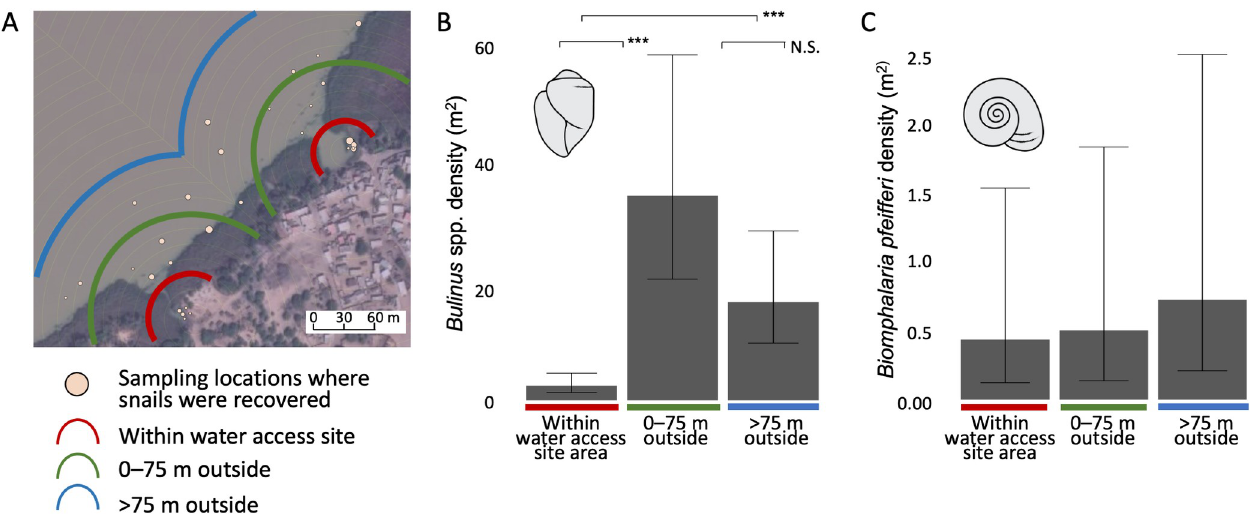
Fig 2. Results from offshore, deep water snail sampling in non-emergent vegetation for three villages located on river settings, and one village located on a lake setting. A) Snails were sampled in three spatial polygons with increasing distances from water access site shorelines: within a discrete water access site (access areas surrounded by emergent vegetation walls, from shorelines to edge of open river channel or lake water), 0 to 75 m outside a water access site area, and 75 m or more outside a water access site area. "Satellite image courtesy of the DigitalGlobe Foundation (now Maxar Technologies, www.maxar. com)." B) Bulinus spp. snails were found at their highest density offshore in non-emergent vegetation outside water access sites, and at their lowest density nearshore inside water access sites. C) Biomphalaria pfeifferi snails were found in equal densities across the three spatial polygons sampled. For each snail species, estimated marginal means are shown with 95% confidence intervals, and p-values for pairwise comparisons were adjusted for multiple comparisons. � p < 0.05, �� p < 0.01, ��� p <